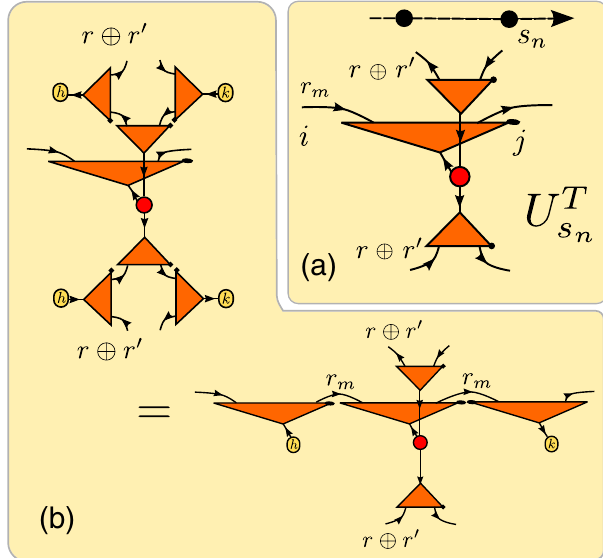
FIG. 14. (a) The U operator in the truncated KS LGT as Ts n defined in Eq. (32). (b) It has by construction the desired covariance properties, meaning that rotations on the physical legs (upperpartofthepanel)aretransmittedtorotationsontheauxiliary legs (lower part of the panel), as described by Eqs. (20) and